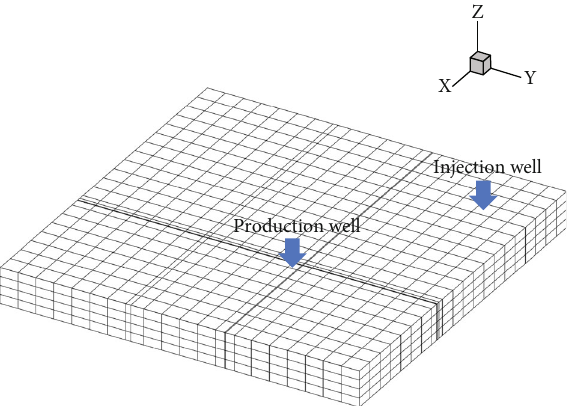
Figure 3: The geological model for Case 2.